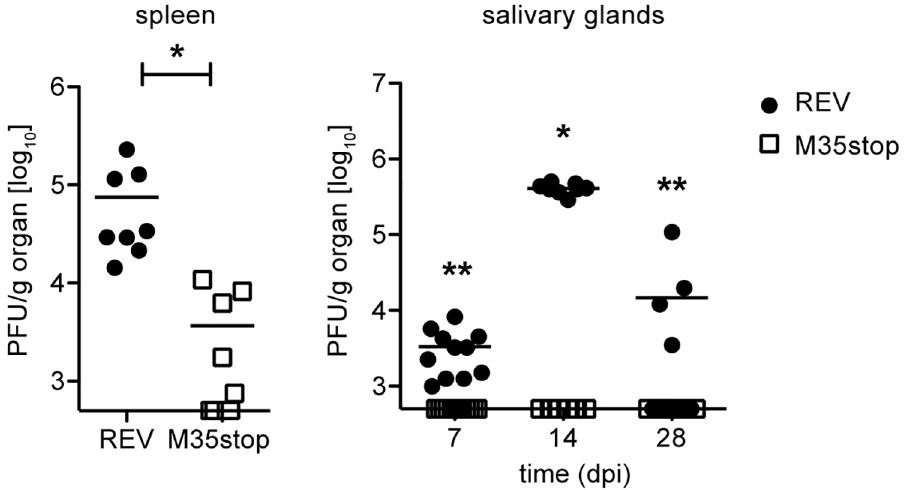
Fig 12. MCMV lacking M35 has a growth defect in the spleen and cannot establish chronic infection in the salivaryglands. MCMV load in the spleen (left panel)and salivary glands(right panel) followingi.v. infectionof BALB/c mice with 2 x 10 5 PFU MCMV-M35stop-REV(REV) or MCMV-M35stop (M35stop). Spleenswere analyzed3 days post infection(dpi) and salivary glands analyzedat indicatedtime points. Viral titers were determined by standardplaqueassay. Data shown is combinedfrom two independent experiments. Each symbol corresponds to an individual mouse; horizontalbars indicatemean values. * p < 0.05, ** p <